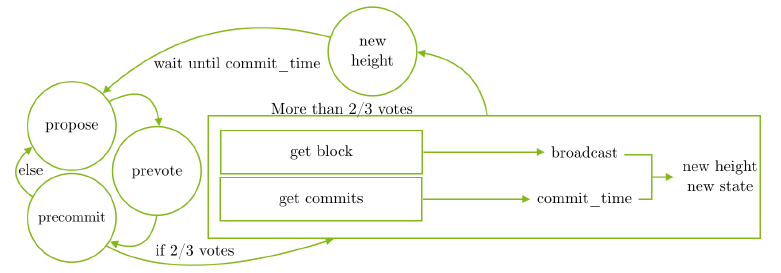
Fig. 3. Consensus protocol rounds for committing new blocks into the blockchain